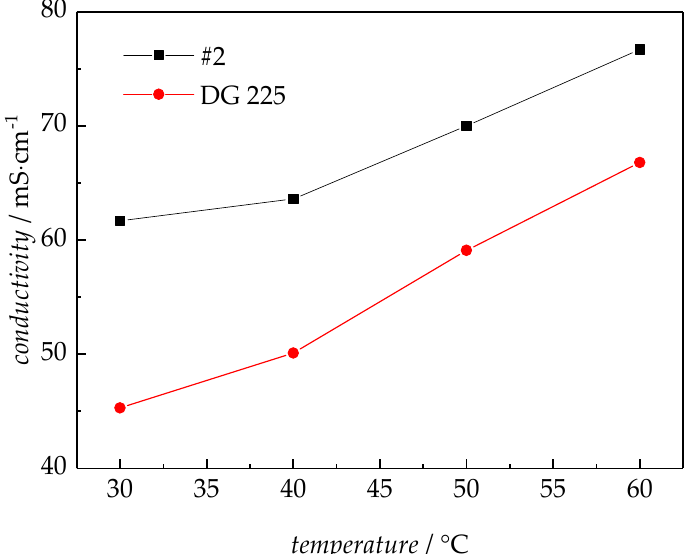
Figure 5. Conductivity in the range of the operating temperature for fuel cell and vanadium redox-flow battery.